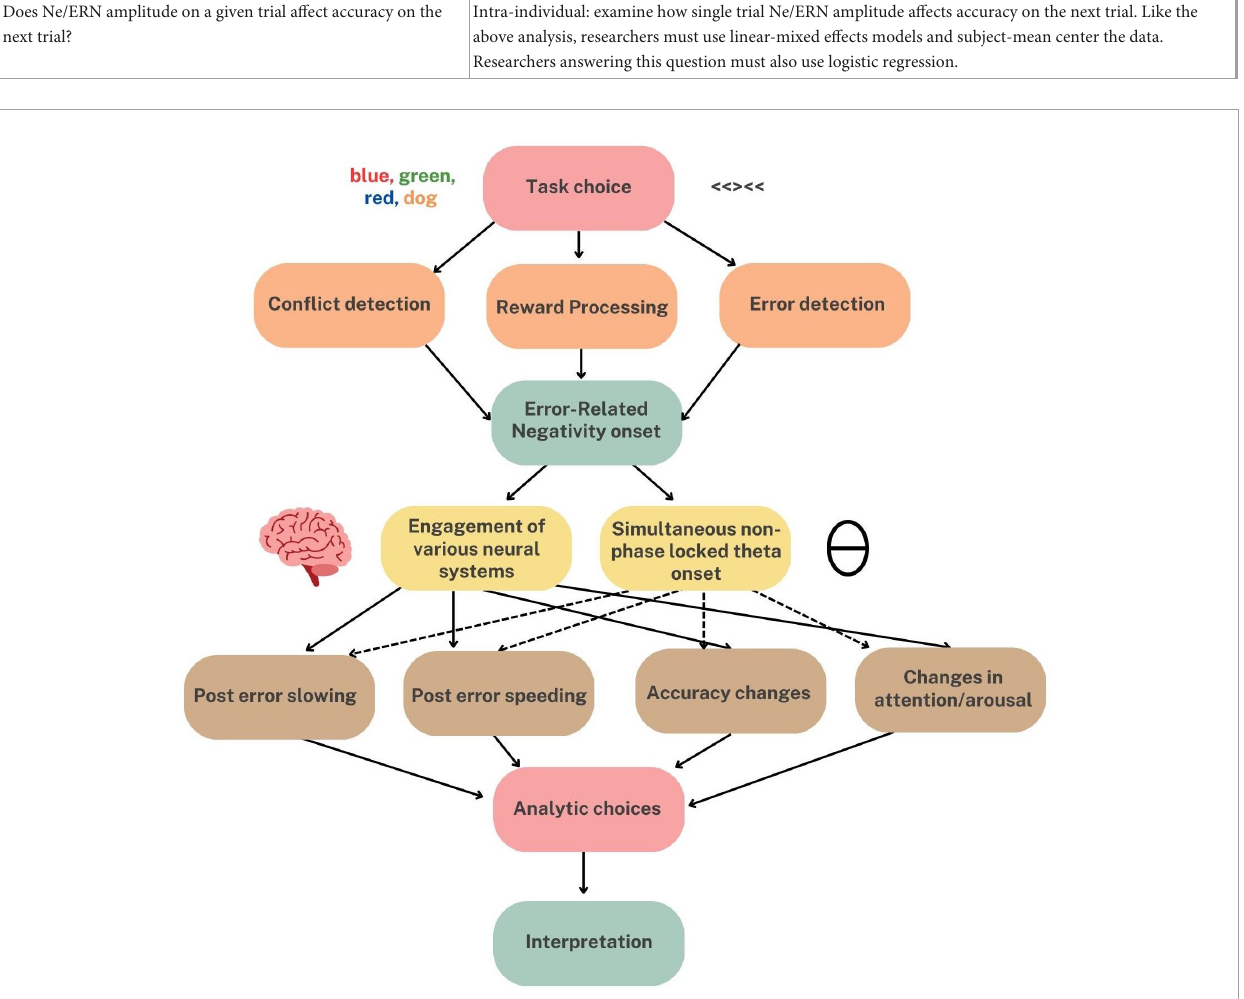
FIGURE1 Example of potential pathways that can influence our interpretations of the relationship between Ne/ERN and behavior. For example, one task might engage underlying “conflict detection” systems more so than error detection to produce an Ne/ERN. From here, differential neural systems might be recruited to implement a variety of behavioral adjustments. Lastly, researcher analytical choices (i.e., pre-processing, number of errors included) can still influence interpretations. This graphic is intended to depict the numerous pathways that can exist to influence results, even within one task paradigm. Original graphic created using Canva.com (© via